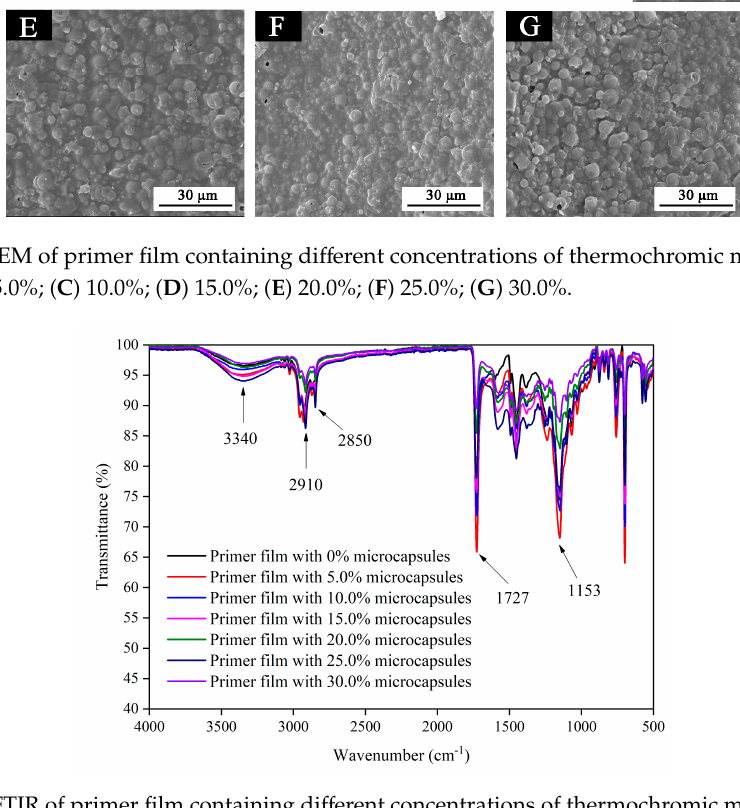
Figure 14. FTIR of primer film containing different concentrations of thermochromic microcapsules.